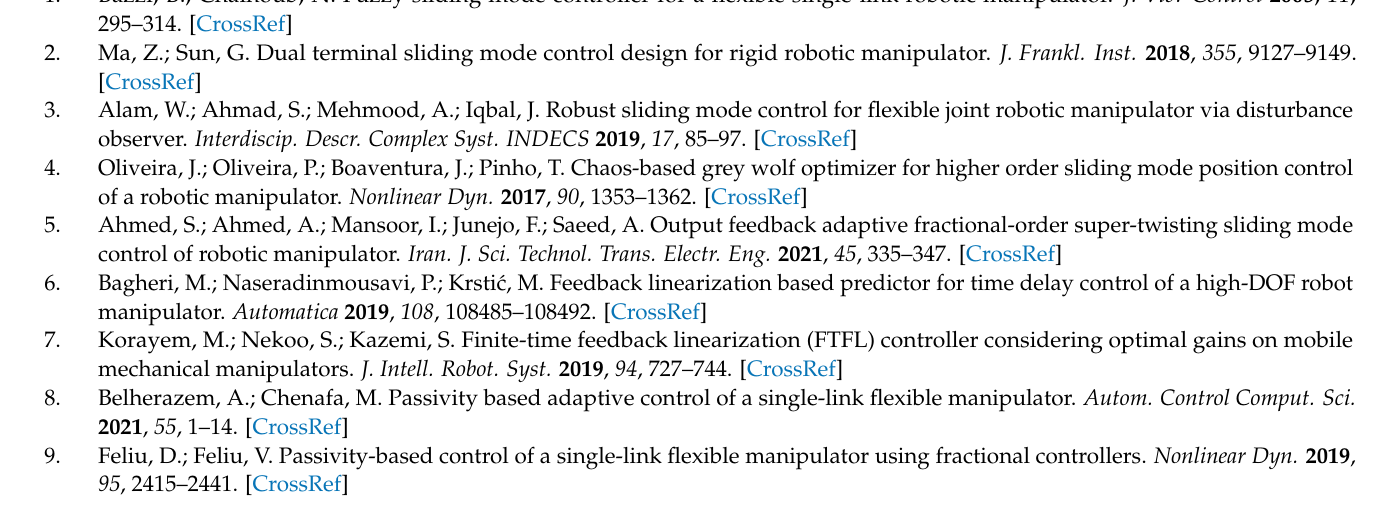
Figure 8. The trajectories of adaptive parameters